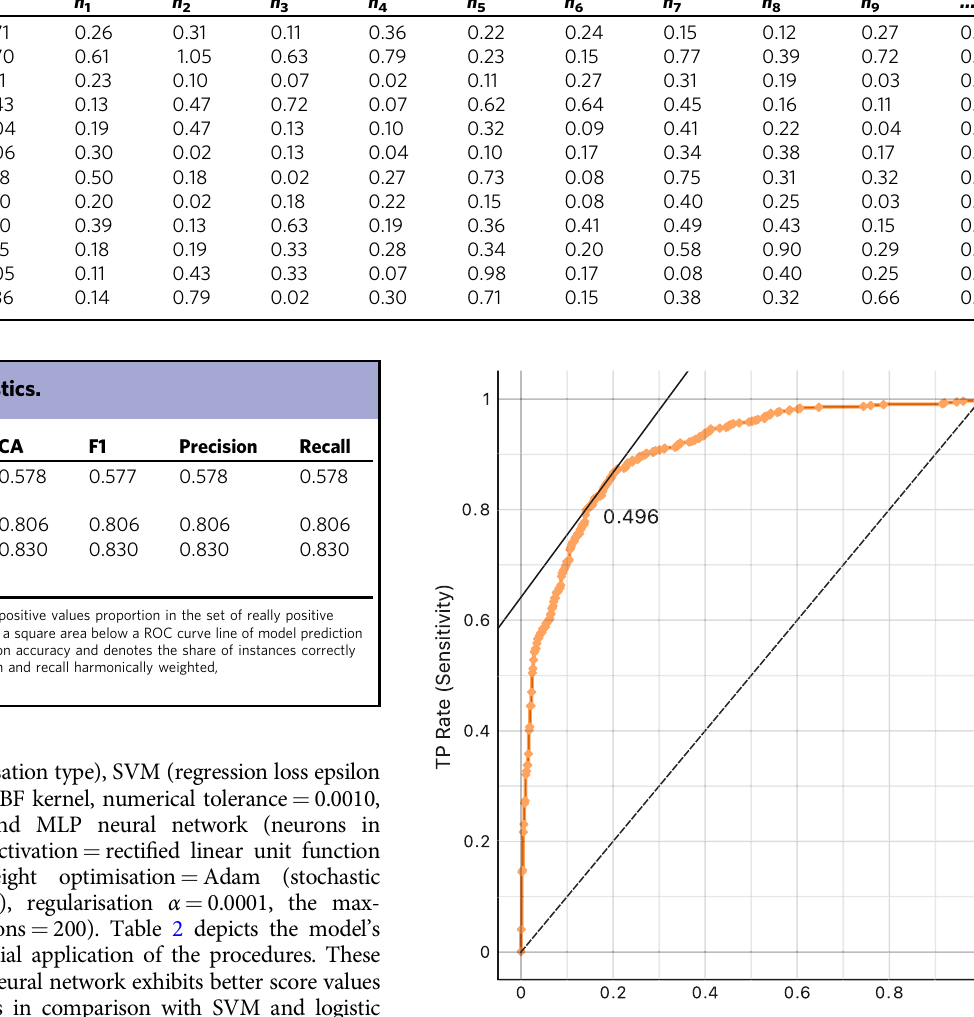
Table 1 The excerpt from the dataset generated by Google ’ s Inception v3 image embedding. Image name